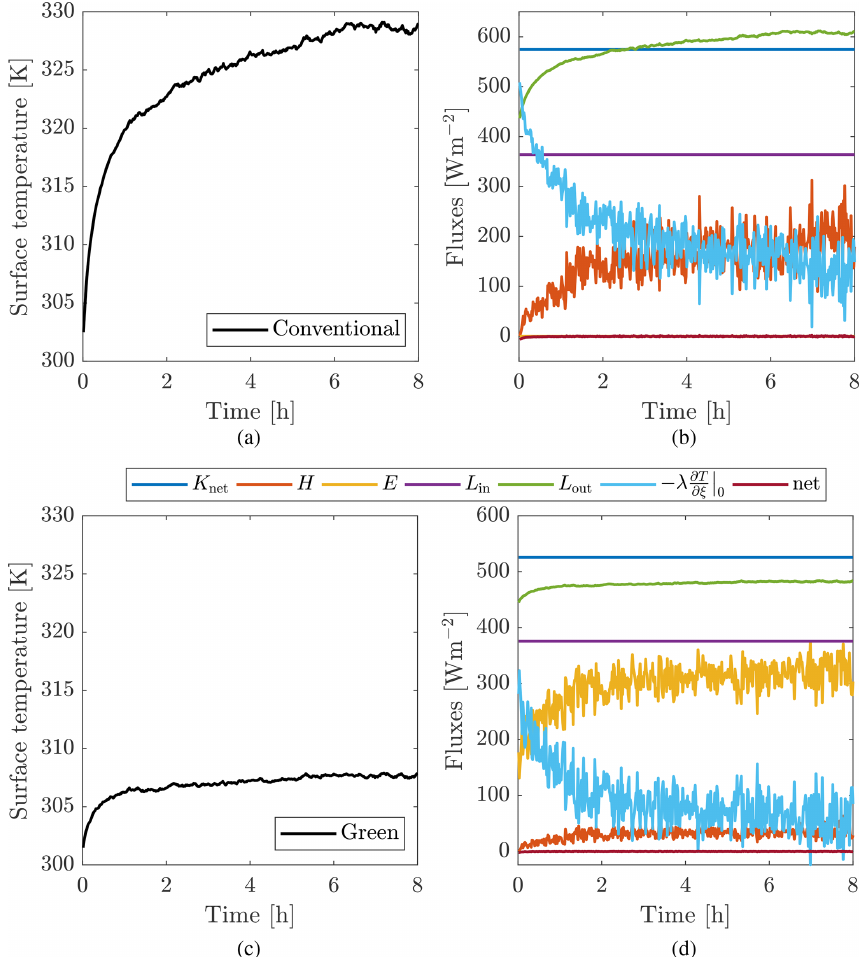
Figure 15. (a) Temperature evolution of a conventional roof facet and the corresponding surface energy fluxes (b) . (c) Temperature evolution of a green roof facet and the corresponding surface energy fluxes (d)